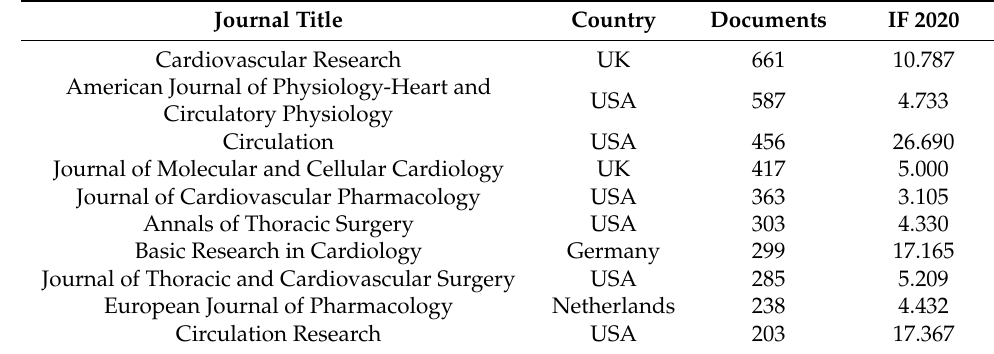
Table 2. Top 10 journals with most publications related to myocardial reperfusion